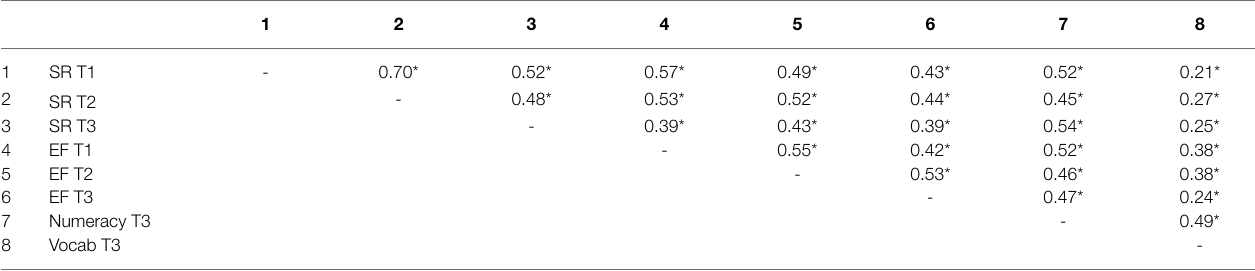
TABLE 3 | Bivariate correlations between modelled